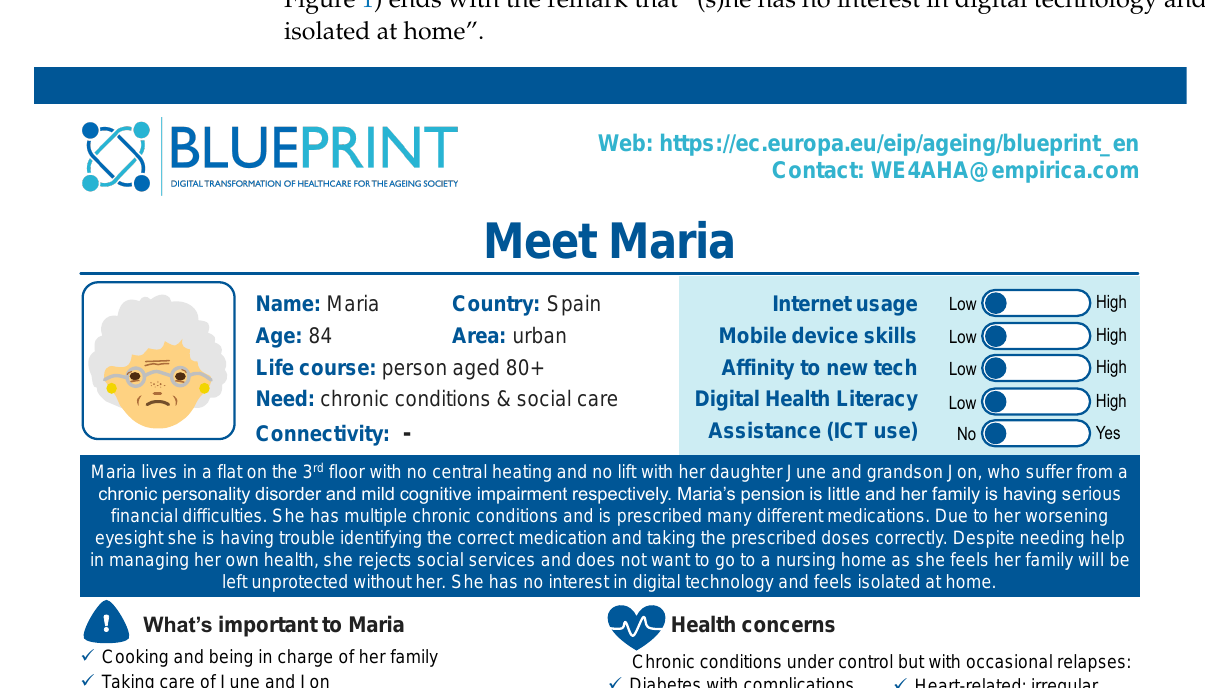
Figure 1) ends with the remark that “(s)he has no interest in digital technology and feels isolated at home”.